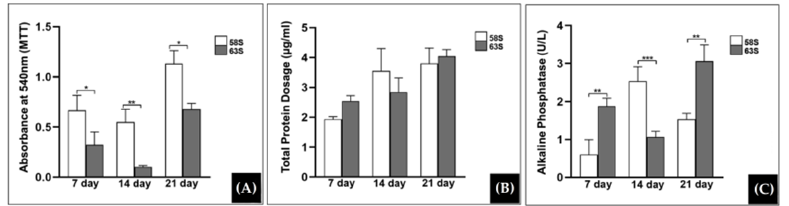
Figure 9. ( A ) MTT activity of MC3T3-E1 cells cultured on studied scaffolds for 7, 14, and 21 days. ( B ) Total protein content ( μ g/mL), up to 7, 14, and 21 days of cell culture of the osteoblastic lineage MC3T3 cultured on the studied scaffolds. ( C ) Alkaline phosphatase activity (U/L) of MC3T3-E1 cells on the studied scaffolds. (* statistical significant differences with p -value < 0.05; ** statistical significant differences with p -value < 0.01; *** statistical significant differences with p -value < 0.001). Reprinted from [23], copyright (2021), with permission from Ceramics International.